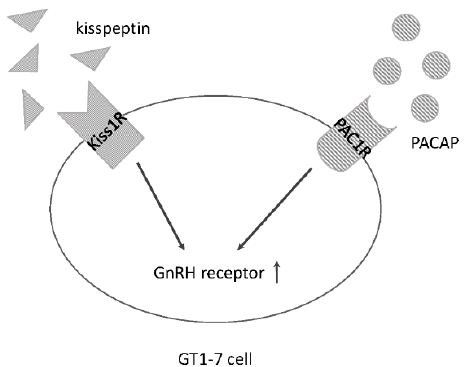
Figure 1. Schematic summary of action of kisspeptin and PACAP in GnRH-producing GT1-7 cells. GT1-7 cells possess Kiss1R and PAC1R, and respond to kisspeptin and PACAP. GnRH receptor expression in GT1-7 cells is increased by these peptides.